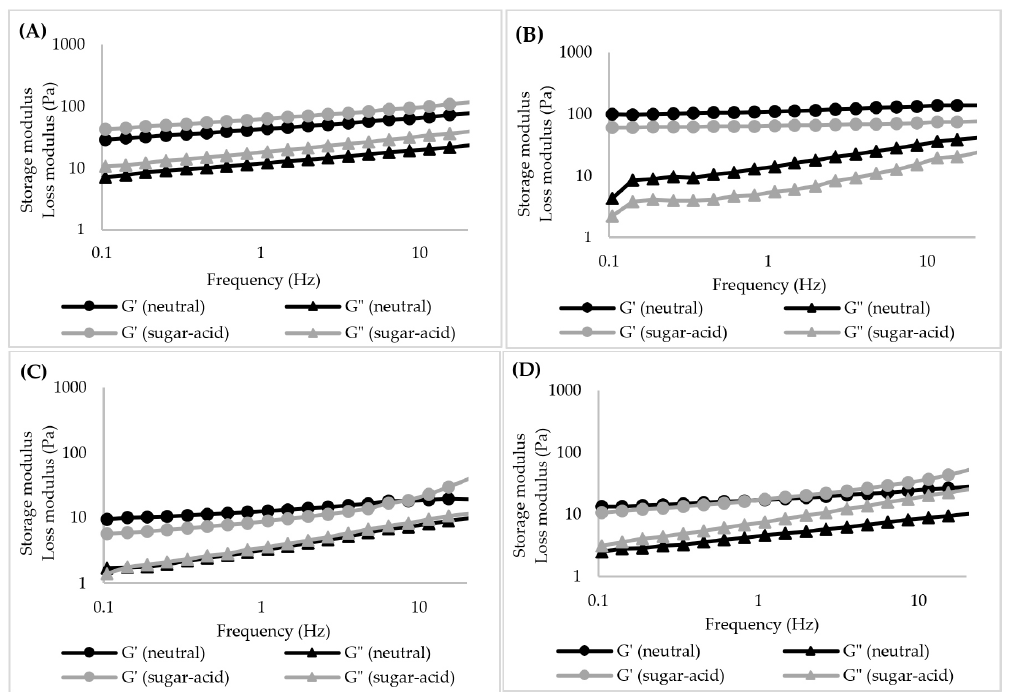
Figure 8. Storage modulus (G ′ ) and loss modulus (G ″ ) of starch gels (6% w / v ) as a function of frequency for the neutral system and sugar–acid system: ( A ): TS, ( B ): RS, ( C ): WTS, and ( D ):